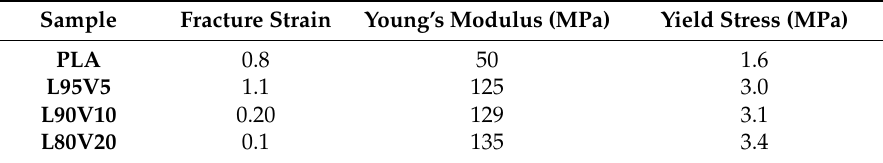
Table 2. Parameters of the tensile properties of PLA and its composites.